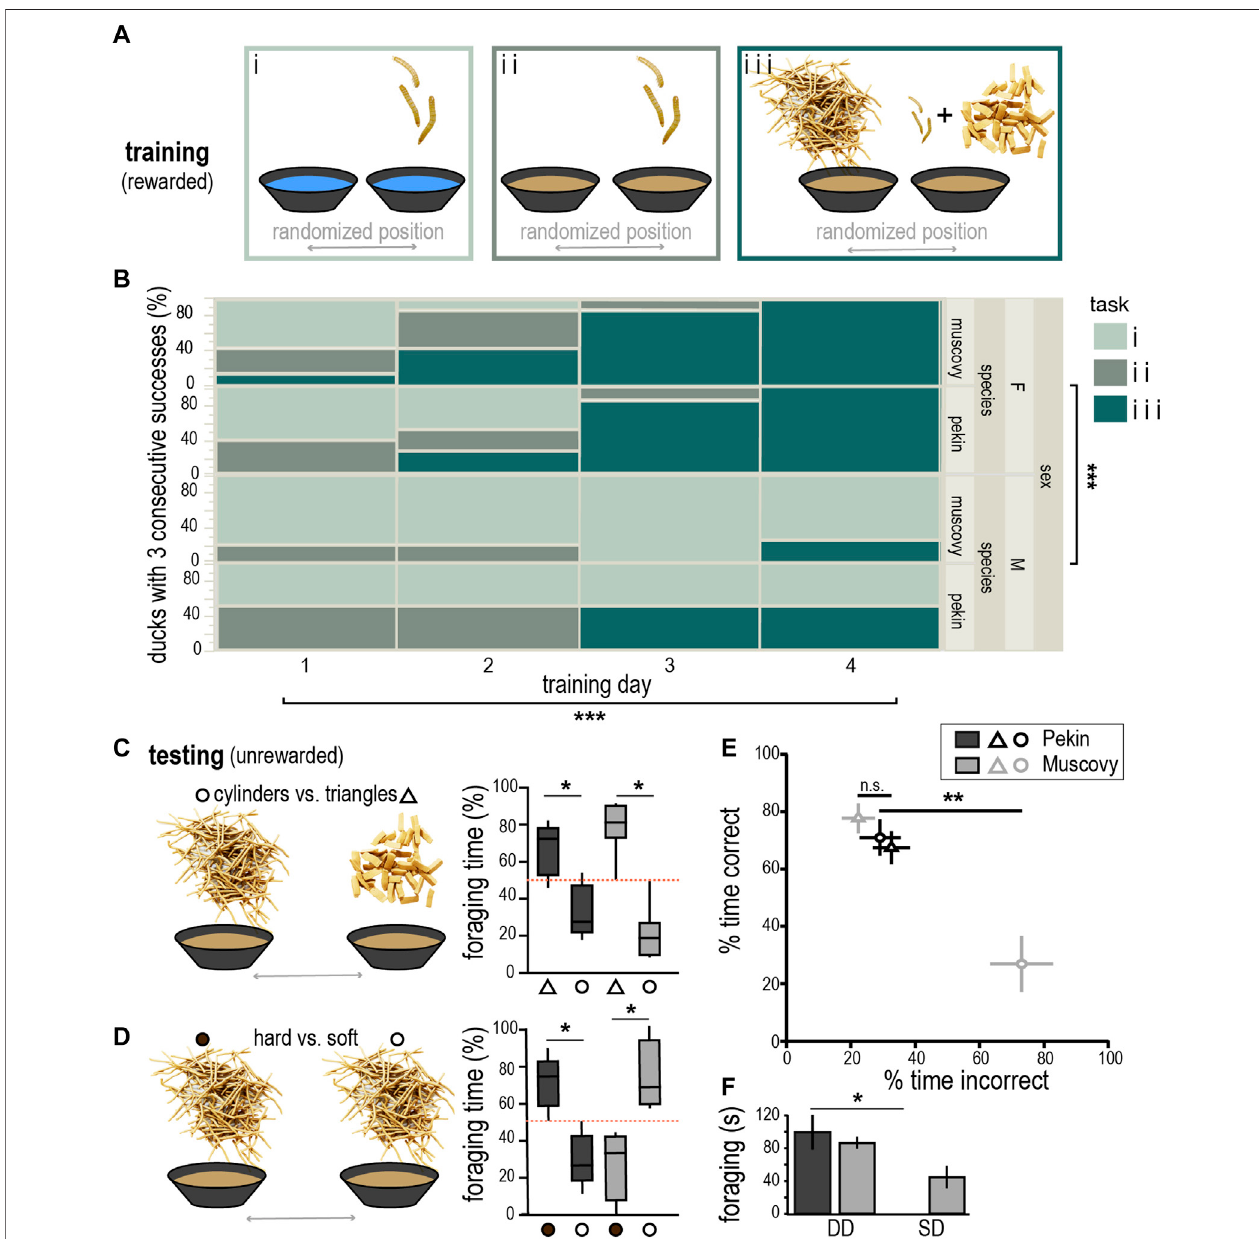
FIGURE 2 | Training and performance on tactile conditioning tasks. (A) Schematic of progressively more dif fi cult tasks (i – iii) used to train ducks to learn shape discrimination (images of worms and plastiline not to scale with bowls, worms in i and ii = 2x scale from iii). (B) Progression of training on tasks i-iii indicating majority of duckslearnedtaskiiiafterfourtrainingdays[nominallogistic fi t,Chi 2 (sex)=16.7,df=2;Chi 2 (trainingday)=23.8,df=6]. (C) Schematicoftestingconditionandboxand whisker plot showing % foraging time in the correct bowl (triangle symbol) or incorrect bowl (circle), red dashed line indicates chance performance, whiskers indicate 10 – 90 percentile. (D) Schematic of hard ( fi lled circles) vs. soft (open circles) testing condition, and box and whisker plot showing behavioral performance as in (C) . (E) Cross-speciescomparison of%timespentinthecorrect(hard)vs.incorrect(soft)bowlsforPekin(black)and Muscovy(grey). (F) Pekinducksspent signi fi cantly more time doing deep dabbling (DD) than surface dabbling/gleaning (SD) on this task, whereas the Muscovy used both foraging strategies. Asterisk indicate * p < 0.5, ** p < 0.01, *** p <